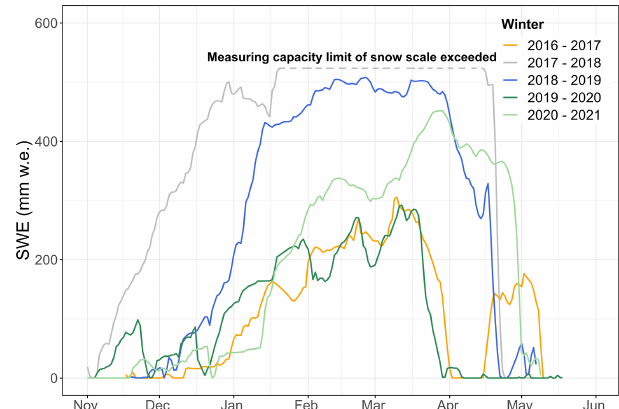
Figure 2. Automatic snow and weather station at Brun- nenkopfhütte, 1602ma.s.l. (image credit: Wolfgang Bogacki). Figure 3. Observed SWE (mm) at the Brunnenkopfhütte snow sta- tion (period: winter